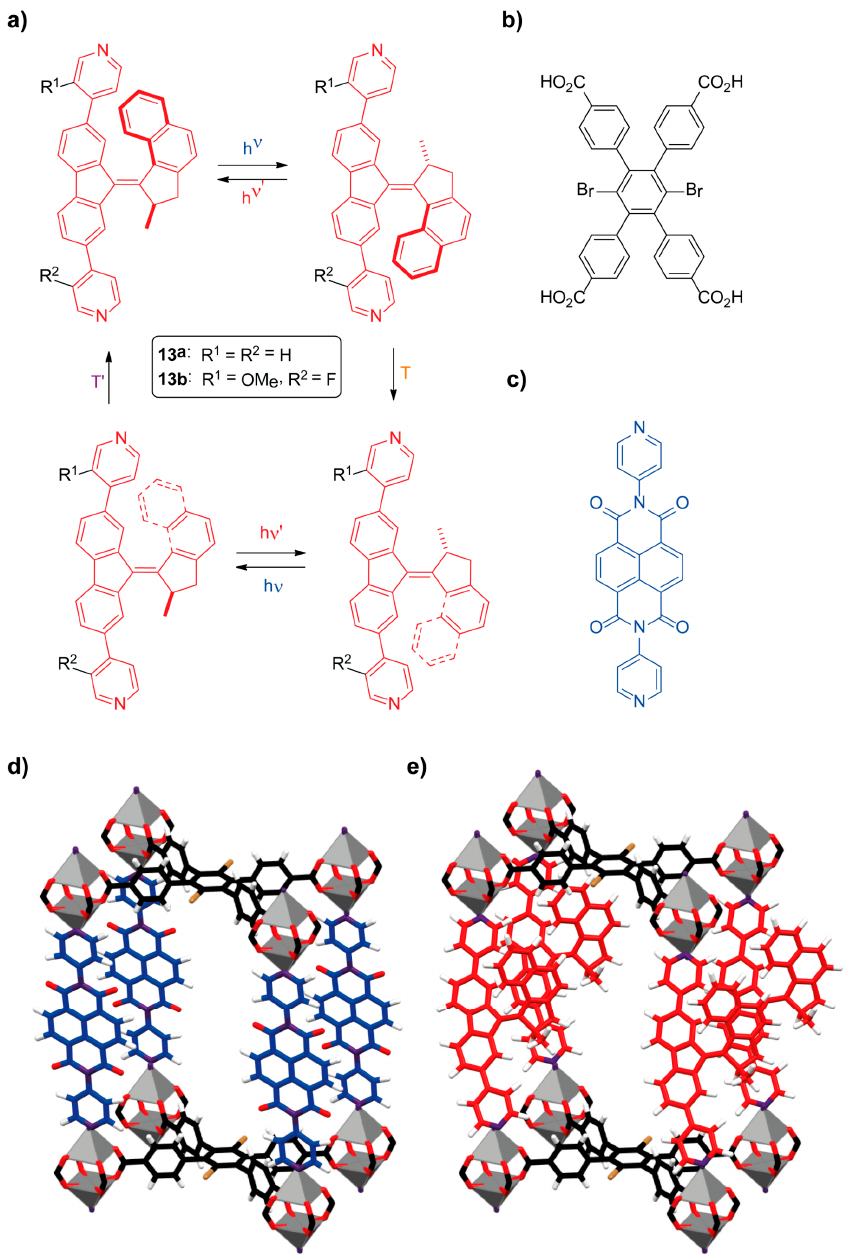
Figure 13. ( a ) Four-step isomerization cycle of the molecular motors 13 [85]; ( b ) chemical structure of TCPB ; ( c ) structure of DPNI ; ( d ) stick representation of the crystal structure of the BrYO-MOF showing a portion of the lattice framework [86]; ( e ) simulated stick schematic representation of the moto-MOF1 containing the overcrowded alkene-based molecular rotor 13a as organic linker [85]. Color key: grey = zinc atoms; black = TCPB carbon atoms; blue = DPNI carbon atoms; red = oxygen atoms and carbon atoms of the overcrowded alkene-based molecular motor linker 13a ; white = hydrogen atoms; brown = bromine atoms; purple = nitrogen atoms.